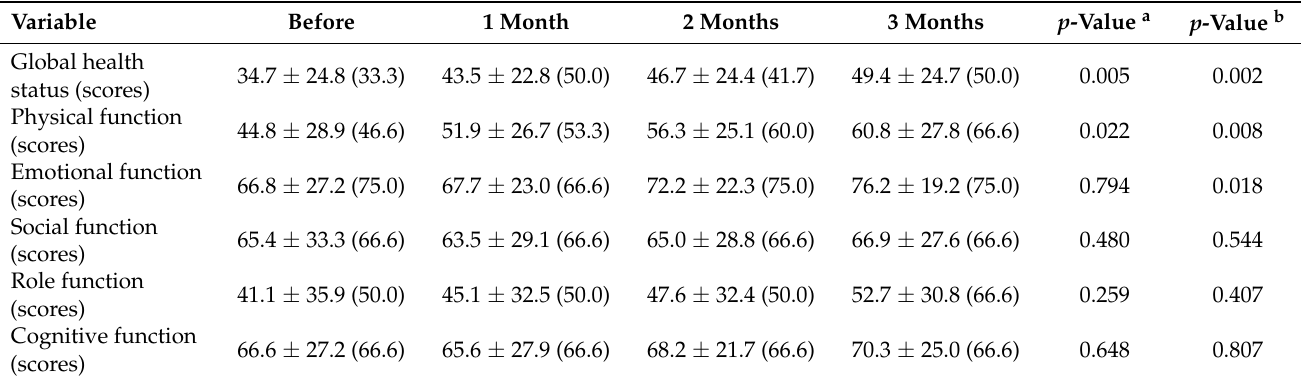
Table 3. Comparisons between quality of life before and after radiotherapy.